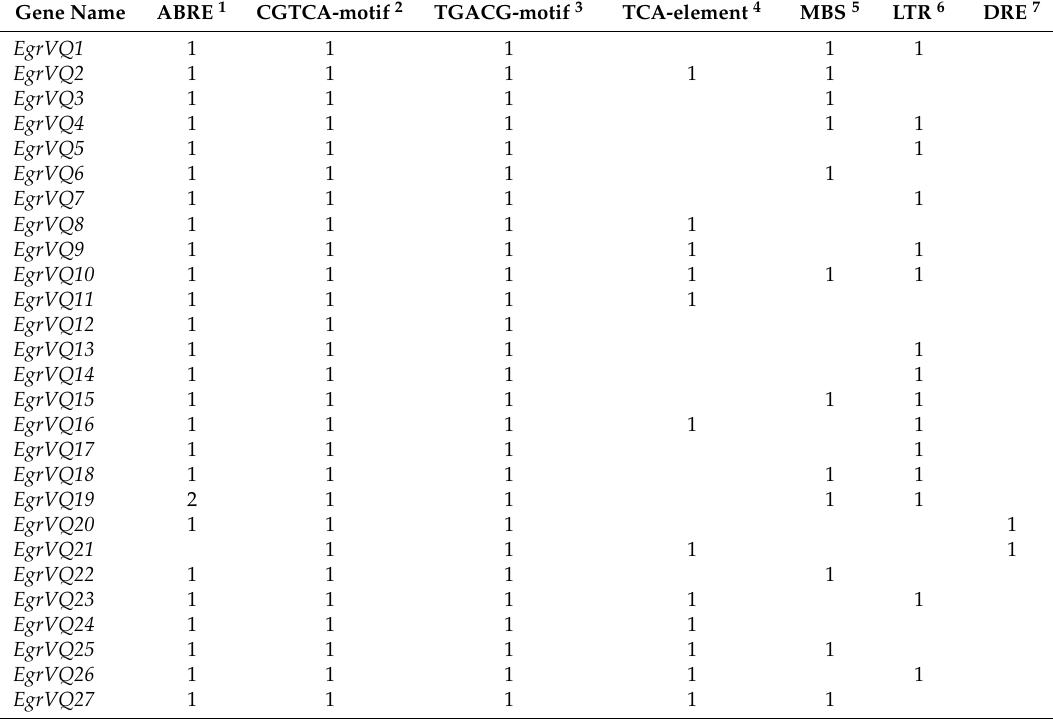
Figure 5. Phylogenetic relationships and conserved motifs of VQ proteins in E. grandis . The left panel showed the phylogenetic tree of EgrVQ, which was constructed by the neighbor-joining method based on the results of sequence alignment. Proteins were divided into seven subgroups (marked by different colors). The right panel showed the distribution of the 20 conserved motifs in the EgrVQ genes following analysis with Multiple Expectation Maximization for Motif Elicitation (MEME). Each specific motif was marked by a different colored box, and the motif numbers were included in the center of each box. The length of each box was proportional to the actual size of the motif. Table 4. Summary of stresses inducible cis -elements in the promoter regions of VQ genes in E. grandis